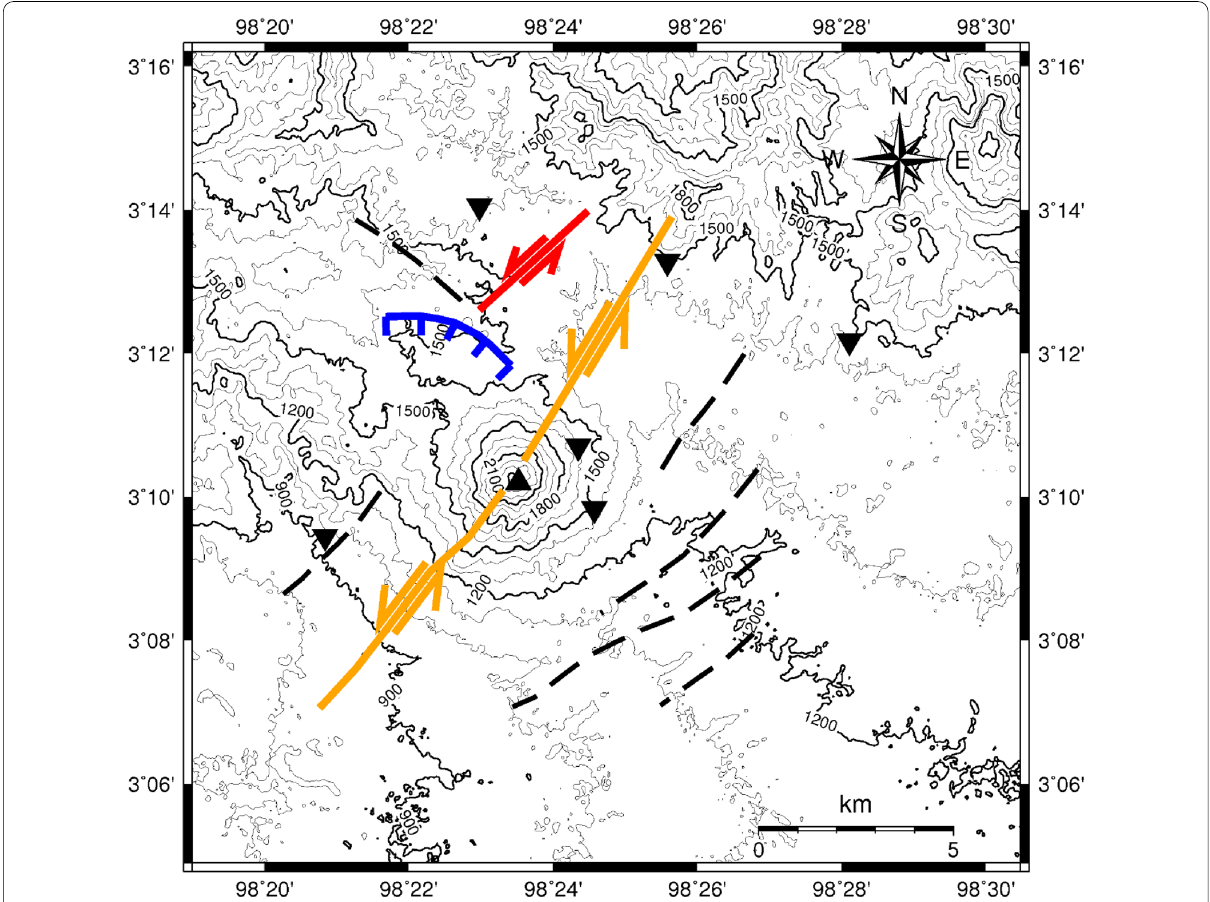
Fig. 9 The proven fault structures from the focal mechanism results are shown by solid black, red and blue lines. The red one is a hidden